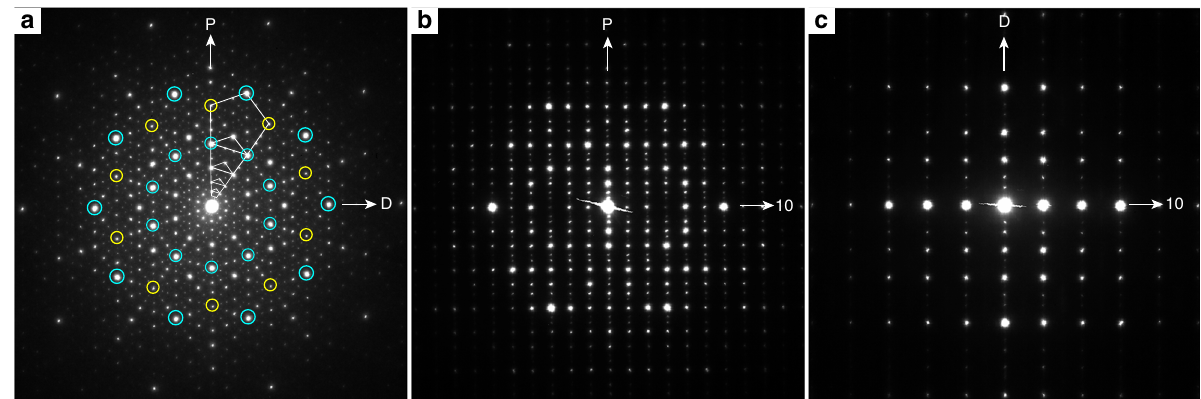
Fig. 1 Characteristic SAED patterns of Al 74 Cr 15 Fe 11 . a Taken along the tenfold axis and b , c , along two typical twofold zone axes, D and P, normal to that in a . The diffraction pattern in a shows an evident tenfold symmetry, e.g., those marked by blue circles. Some features are marked in a demonstrating the scaling properties of the diffraction pattern by powers of τ = 1.618, as visualized by pentagons of varying size. Every other reciprocal lattice layer is systematically extinct in c , indicating the existence of a c -glide plane and, intrinsically, a 10 5 screw